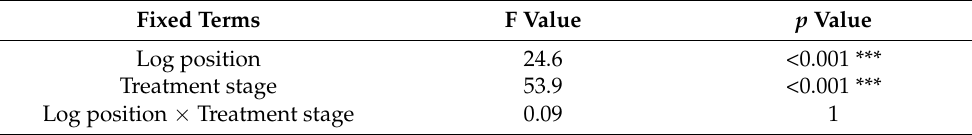
Table 2. Significance of log position and treatment stage on modulus of elasticity (measured as MOE dyn ) of the boards. The repeated measures model considers log position (degrees of freedom (df) = 3) and treatment stage (df = 3) and their interaction (df = 9) as fixed terms. The residual degrees of freedom are 1042.